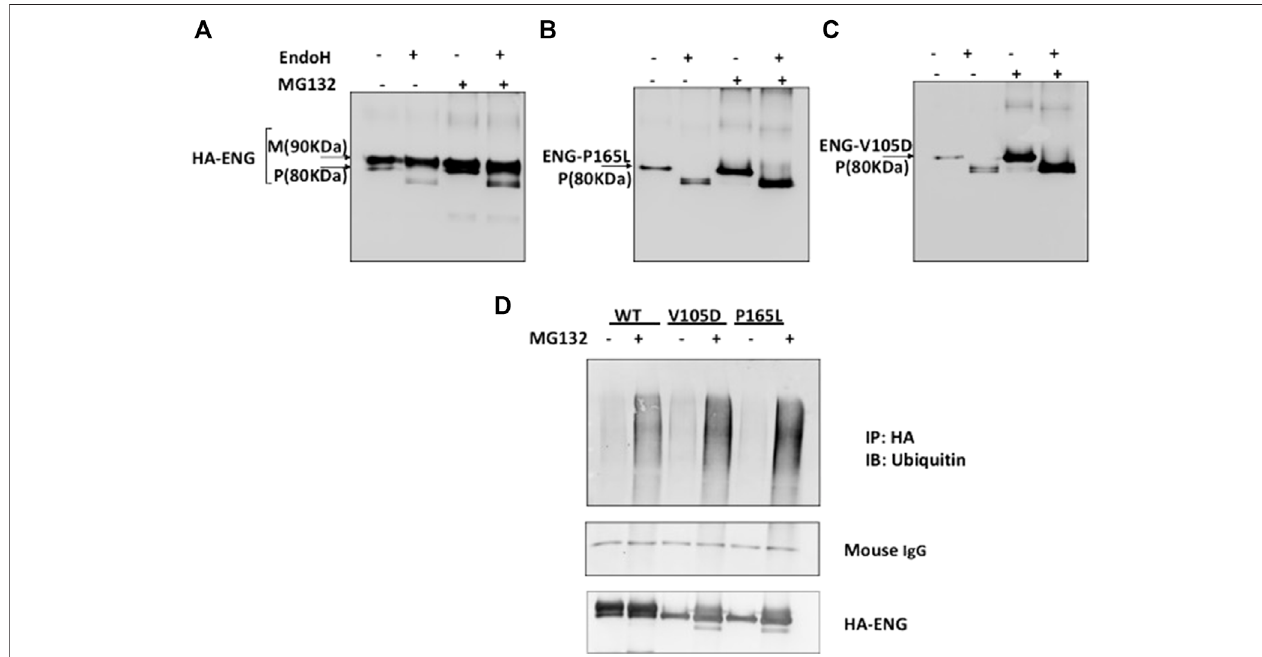
FIGURE 2 | Proteasomal inhibition of WT Endoglin and mutant Variants P165L and V105D in transiently transfected HEK 293 cells. (A – C) Immunoblots of immunoprecipitatedEndoglinspecies(WT,P165L,andV105D)digestedwithEndoHaftertreatmentwithproteasomalinhibitor(MG132)(10 μ M).Endoglinmatureband at 90 KDa is indicated by (M) and precursor band at 80 KDa is indicated by (P). (D) Immunoprecipitated Endoglin WT and mutant variants P165L and V105D were treatedwith10 μ MMG132(+)orDMSO( − )for16 h.Theimmunoprecipitateswereimmunoblottedwithantibodiesagainst Ubiquitin. MouseIgGfrom IPbeads are shown as loading control. The ubiquitin blots were stripped and re-probed against HA for con fi